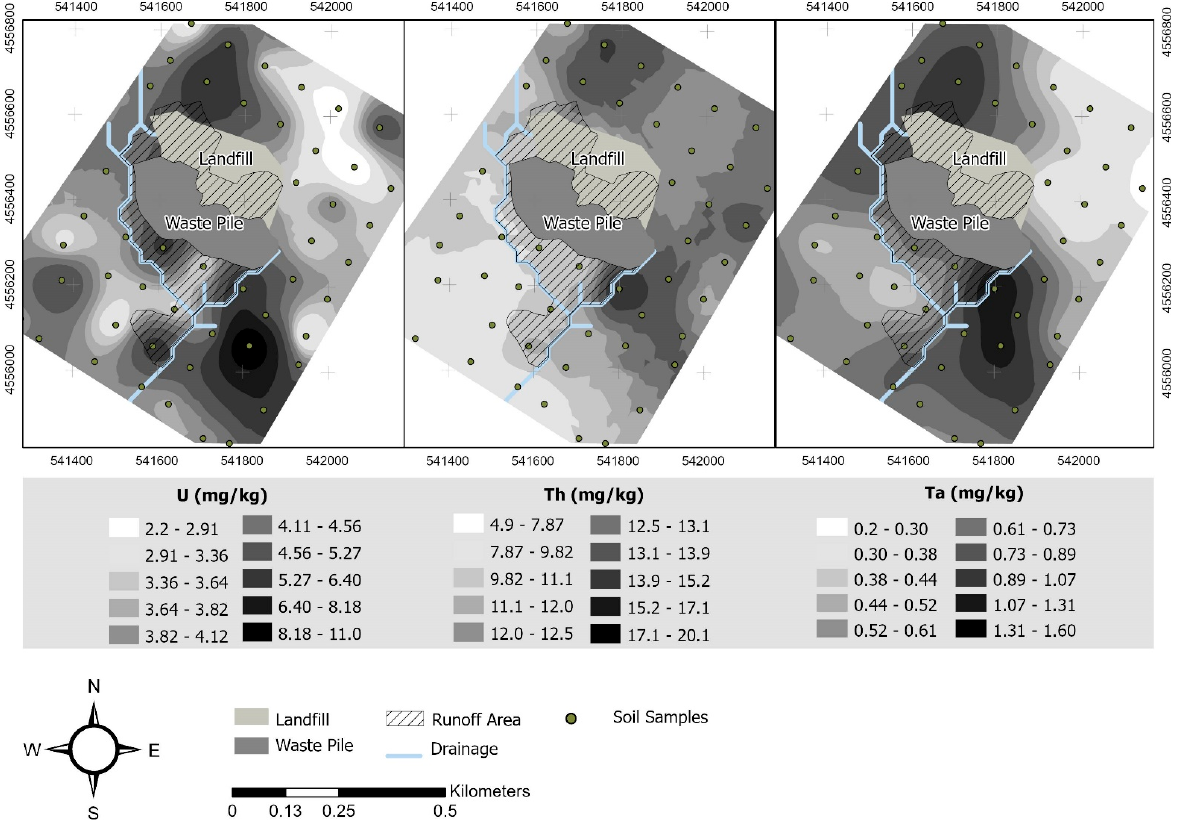
Figure 9. Spatial distribution of U, Th, and Ta in the soils that surround the São Pedro da Cova waste pile, interpolated by ordinary kriging.